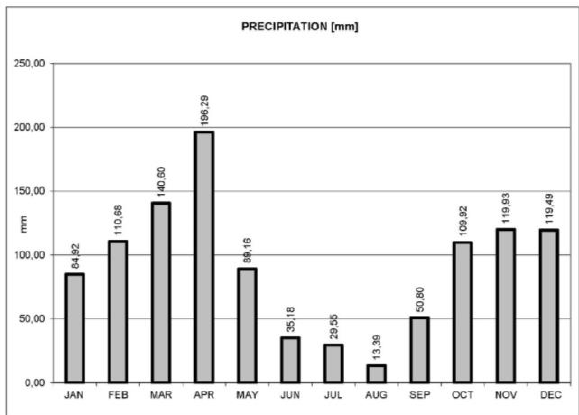
Table 2. Average rainfall 2000-2012, INAMHI.